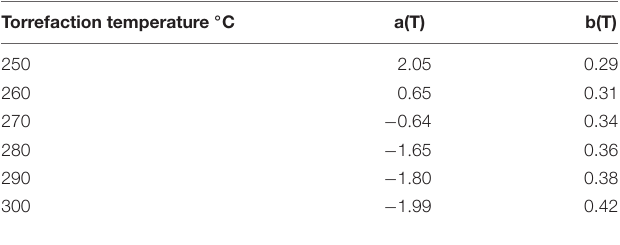
TABLE 6 | Endothermic and exothermic heat of torrefaction reaction at different temperatures in this study and literature data. Present work Peng et al. (2013) Spruce